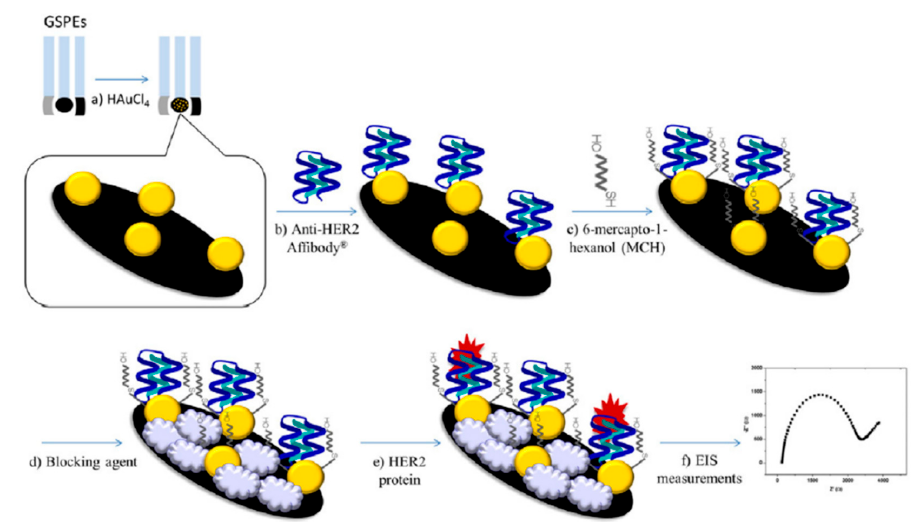
Figure 7. Affibody-sensor for the detection of human epidermal growth factor receptor 2 (HER2) biomarker. ( a ) Preparation of AuNP–graphite strip through electrodeposition. ( b ) Anti-HER2 immobilization over the AuNP–graphite strip. ( c ) Formation of MCH self-assembled monolayer with the anti-HER2 AuNP–graphite strip. ( d ) Addition of blocking agent to the electrode strip. ( e ) Interaction with HER2 and ( f ) the corresponding impedance signal [100]. Reprinted with permission from [100], Copyright © 2020 Published by Elsevier B.V. GSPEs: Graphite screen-printed electrodes, EIS: Electrochemical impedance